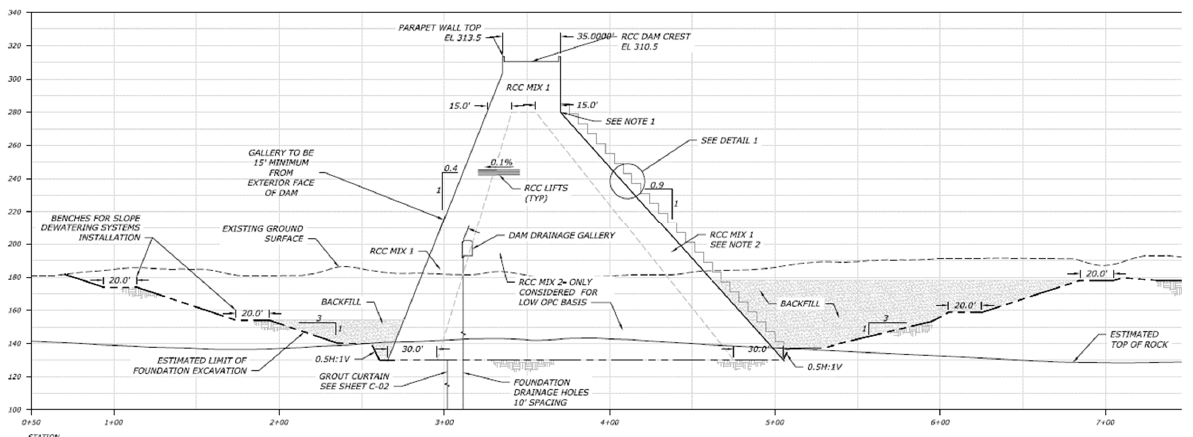
Figure A3. Representative maximum (non-overflow) cross-section of the Scoggins RCC Dam.